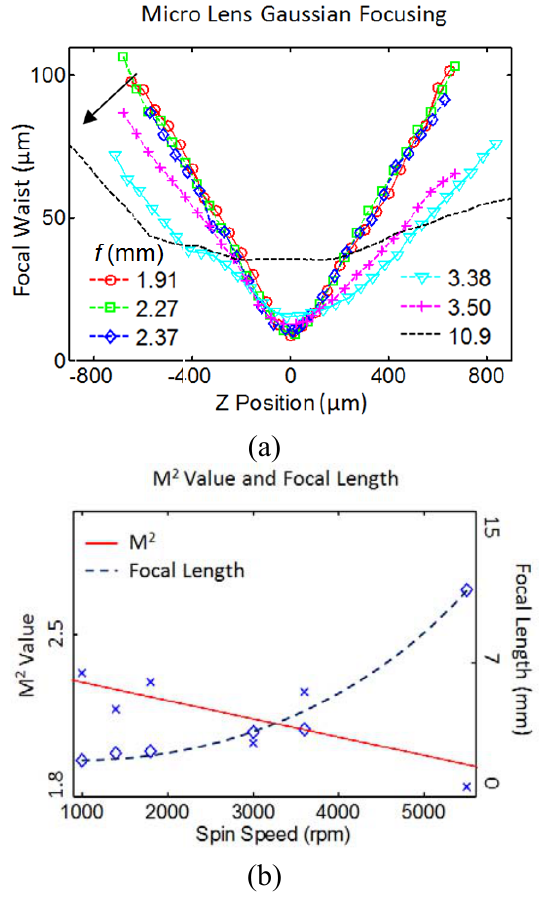
Figure 5. (a) Measured radii along the focal axis of six microlens diaphragms with arrow showing increasing focal length ( f in mm). (b) M 2 value is plotted on the left scale, while focal length is plotted on the right scale. Higher speed on the horizontal axes yields thinner initial resist, with a fixed 1.2 mm diameter, higher speed also yields lower aspect